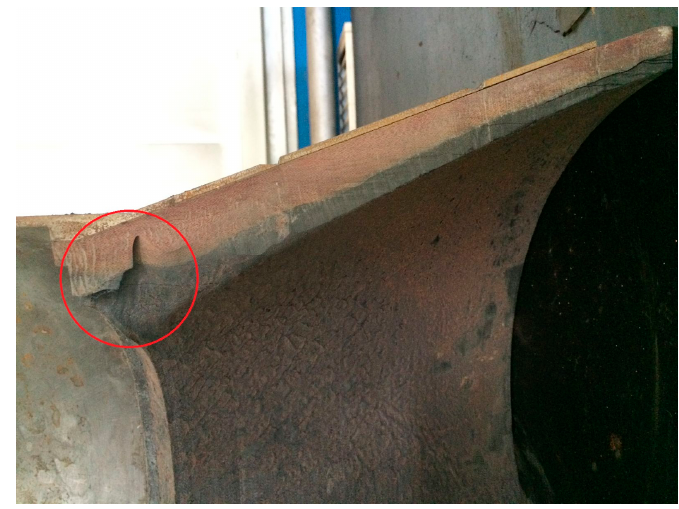
Figure 16. Divergent region after the experiment.